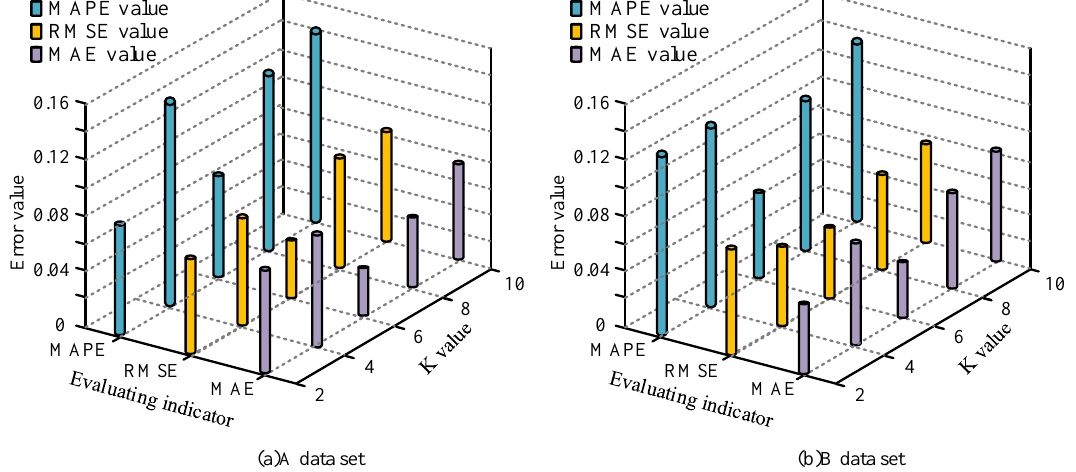
Figure 6. Comparison of prediction errors of VMD-GRU algorithm models under different K val- ues.